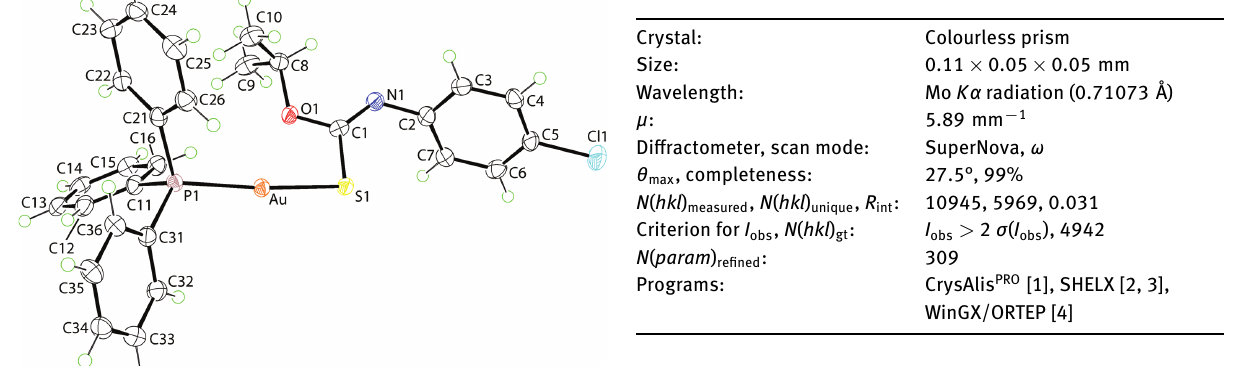
Table 1: Data collection and